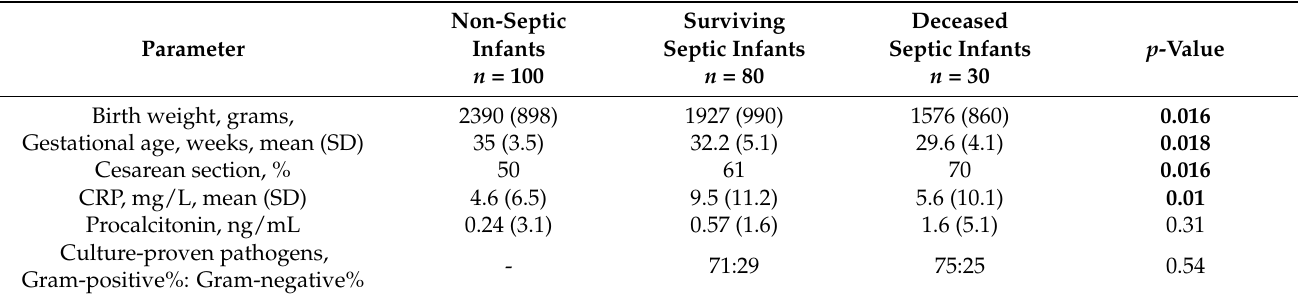
Table 2. Clinical characteristics between groups of the neonatal cohort.